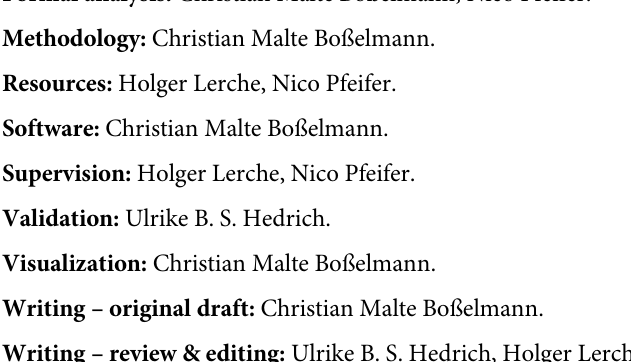
S1 Table. Variants used for external validation. Details on data curation and validation pro- cedure are available in the Methods section. Primary disease corresponds to the core pheno- type, while phenotype terms refers to the information provided to the MKL model. For the decision rule, exact matches are shown in bold. Abbreviations: BrS–Brugada syndrome; DEE–